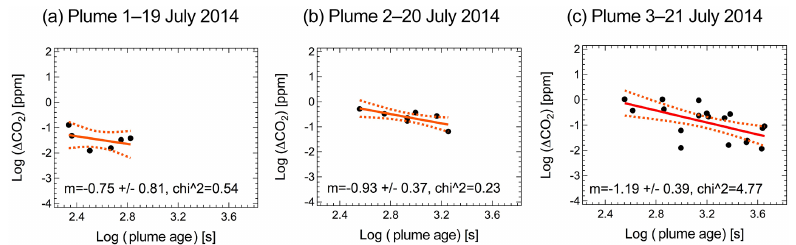
Figure 9. Calculated plume growth or expansion rate ( γ = − m ) along the flight tracks using aircraft measurements for plumes 1 (a) , 2 (b) , and 3 (b) . Note: using the methodology in Sect. 2.2.5 a plume age could be assigned to n = 6 data points for plume 1, n = 7 data points for plume 2, and n = 18 data points for plume 3.